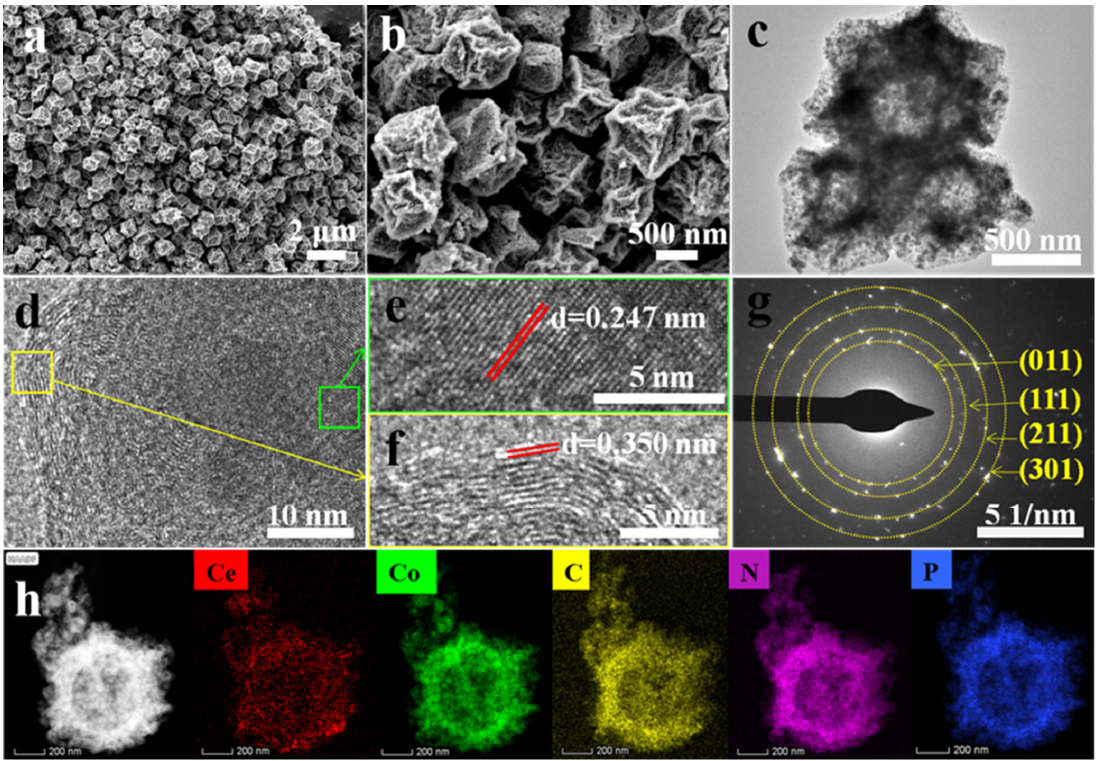
Figure 4. ( a , b ) SEM images, ( c ) TEM image, ( d – f ) HRTEM images, ( g ) selected-area diffraction